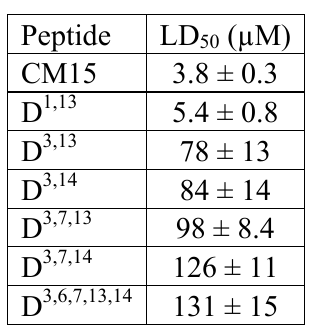
Table 3. Toxicity of CM15 and D-lysine diasteromers to RAW264.7 murine macrophages.